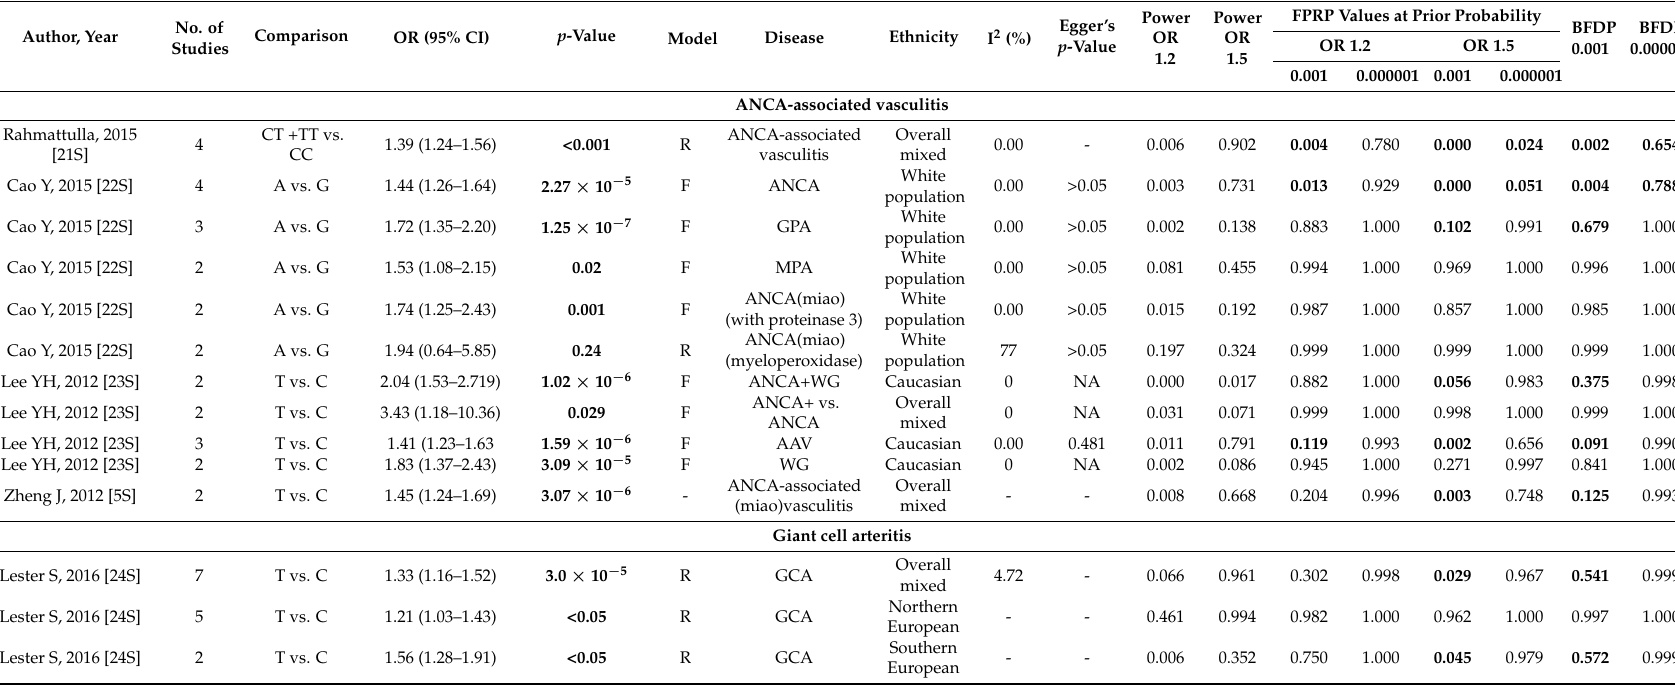
Table 4. Meta-analysis results of associations between vasculitides and the PTPN22 1858 C/T polymorphism from observational